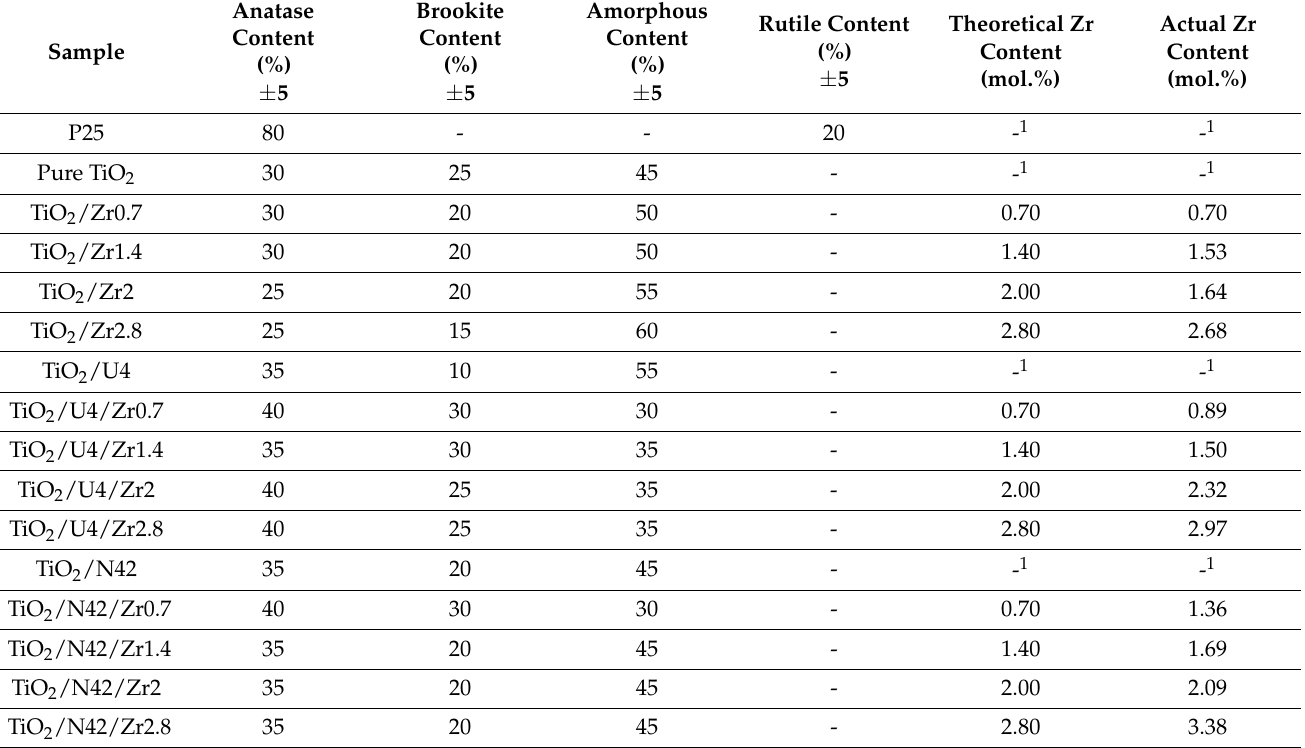
Table 1. Quantitative analysis of samples’ crystallinity and dopant content by XRD.